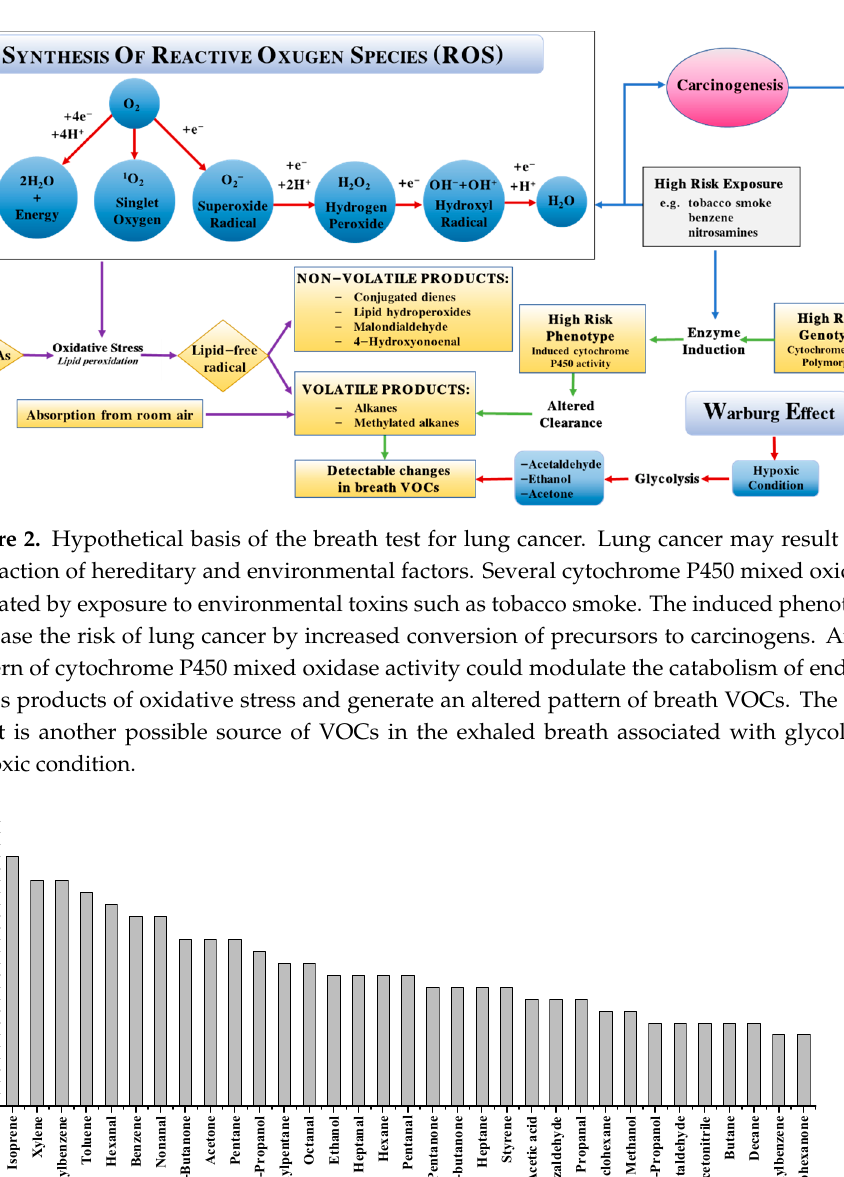
developed a model comprising 20 VOCs that achieved 93.9% accuracy in distinguishing between non-small cell lung cancer (NSCLC) and small cell lung cancer (SCLC), and an- other model composed of 19 VOCs that could differentiate between early and late-stage lung cancer with an accuracy of 82.7% [8]. Nevertheless, the most prevalent method used for exhaled breath diagnosis entails the application of large instruments such as GC–MS. While effective in detecting low-concentration VOCs, they have limitations, such as complexity, high costs, and lack of portability, hindering their widespread use in routine home check-ups. Furthermore, they cannot provide real-time analysis. In a prospective study, Peled et al. used GC–MS and a gas sensor to detect the exhaled breath in 72 pa- tients with lung nodules, and the latter selectively distinguished between benign and